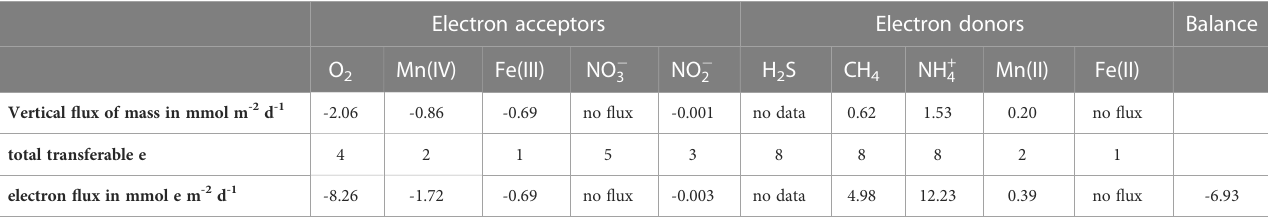
TABLE 1 Downward vertical fl uxes of electron acceptors (oxidants) and upward vertical fl uxes of electron donors (reductants) at the oxycline (35 m) in September 2020.